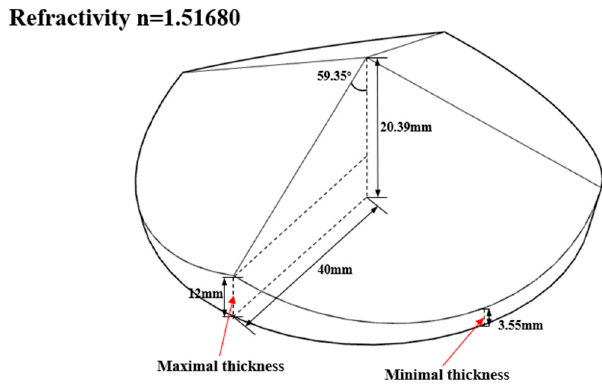
Figure 7. The geometry of the pyramidal prism.